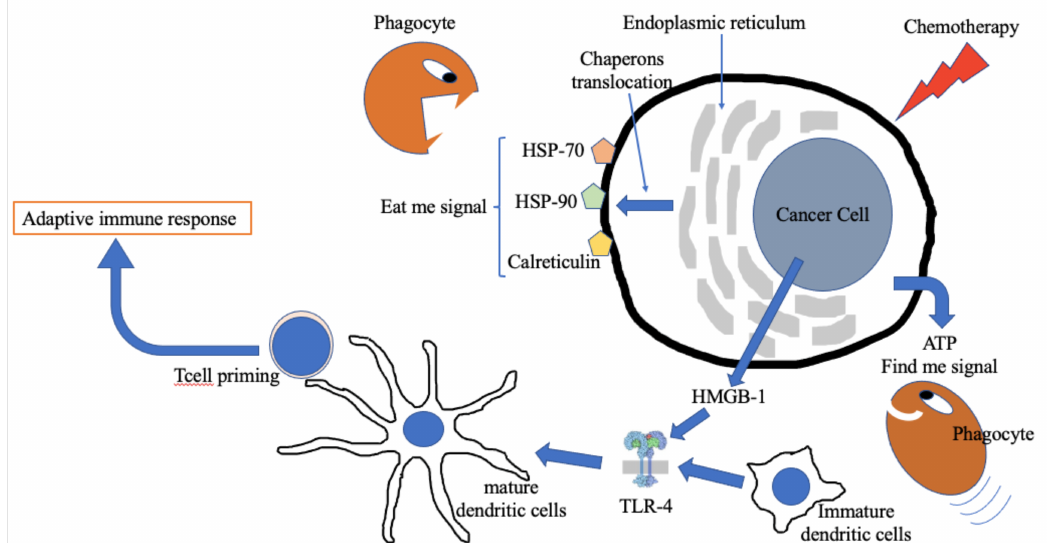
Figure 1. Immunogenic cell death. Under chemotherapy attack, cancer cells initiate a series of modifications favoring the activation of the immune system. ATP is released in the microenvironment by injured cells, representing a “find me signal” able to attract phagocytes. Many chaperons expressed in the endoplasmic reticulum translocate to the cell membrane representing an “eat me signal” that can be recognized by phagocytes. HMGB1 released in the extracellular fluid under cell stress conditions favors dendritic cell maturation via TLR-4 activation. HSP = heat shock protein; ATP = adenosine